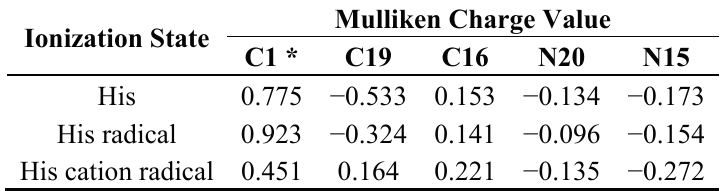
Table 5. The Mulliken charge distribution in His and corresponding radical and cation radical.